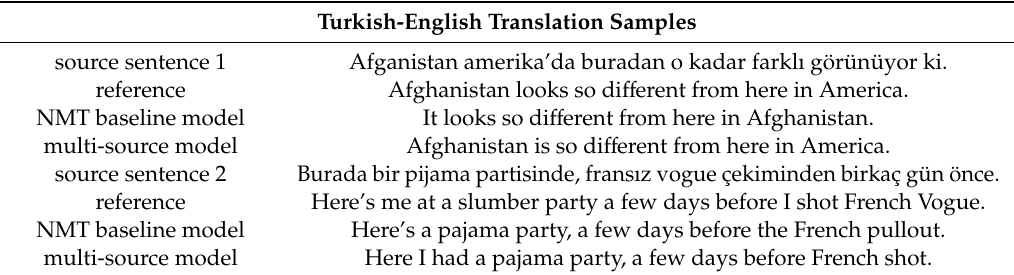
Table 8. The translation samples for the di ff erent NMT models for the Turkish–English translation